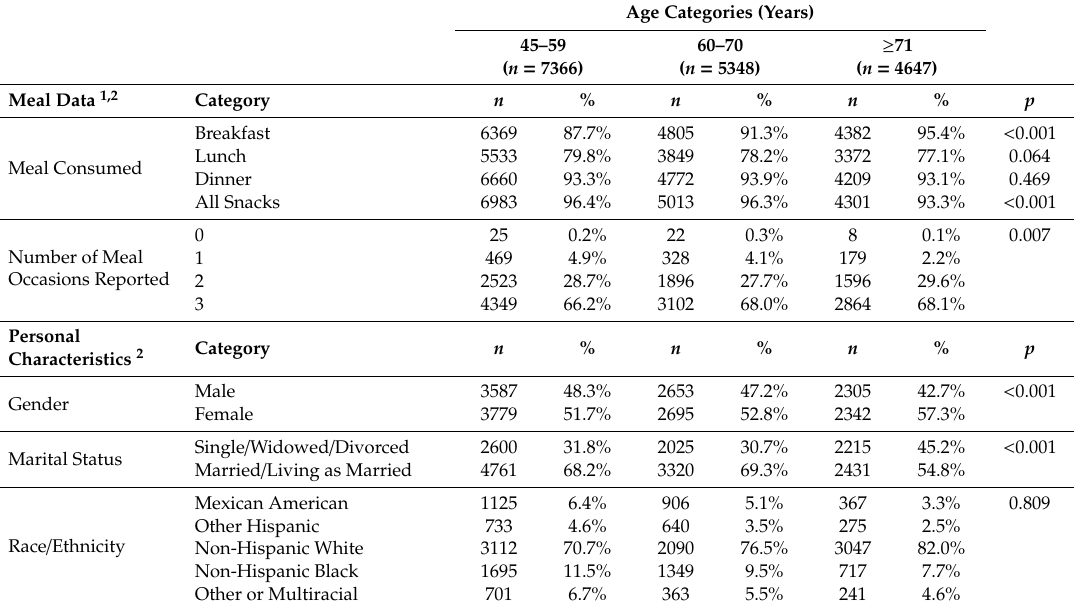
Table 1. Personal characteristics and proportion of adults consuming meals and snacks, categorized by